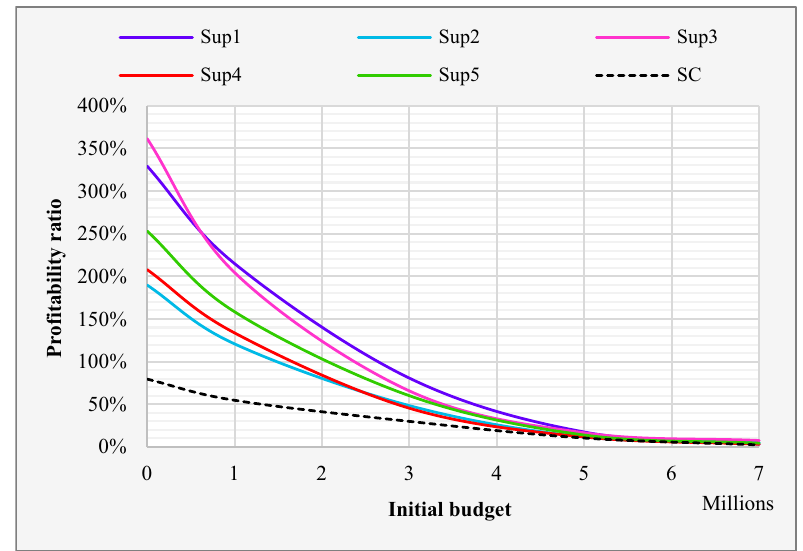
Fig. 14 The result of analyzing the sensitivity of the suppliers’ and SC’s profitability ratio to the changes in the initial